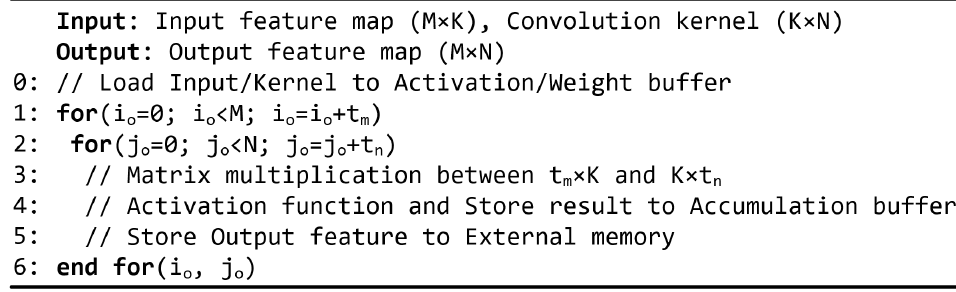
Figure 9. Pseudocodes of convolution operations in a convolution layer.